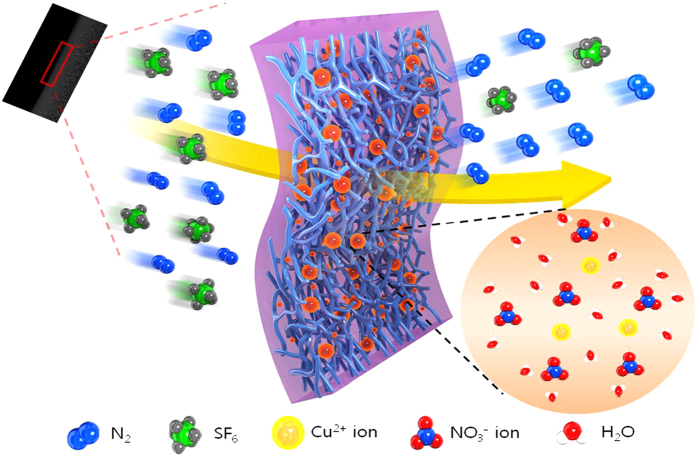
Polymer electrolyte membrane for SF6 separation.